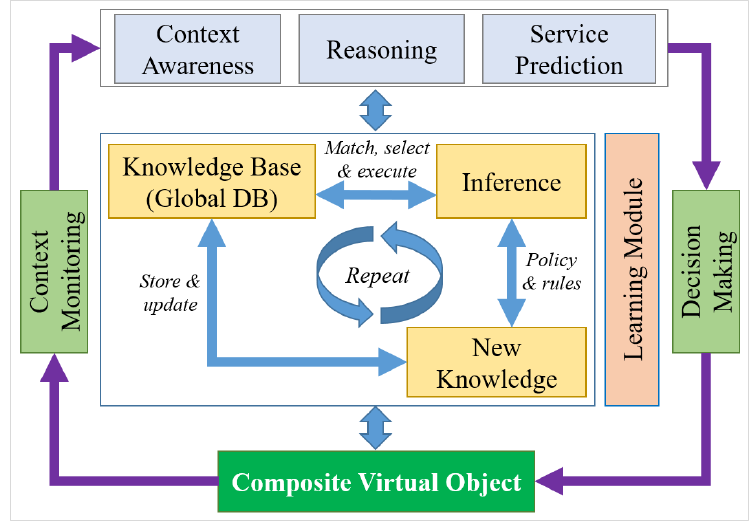
Figure 14. Knowledge-based service creation